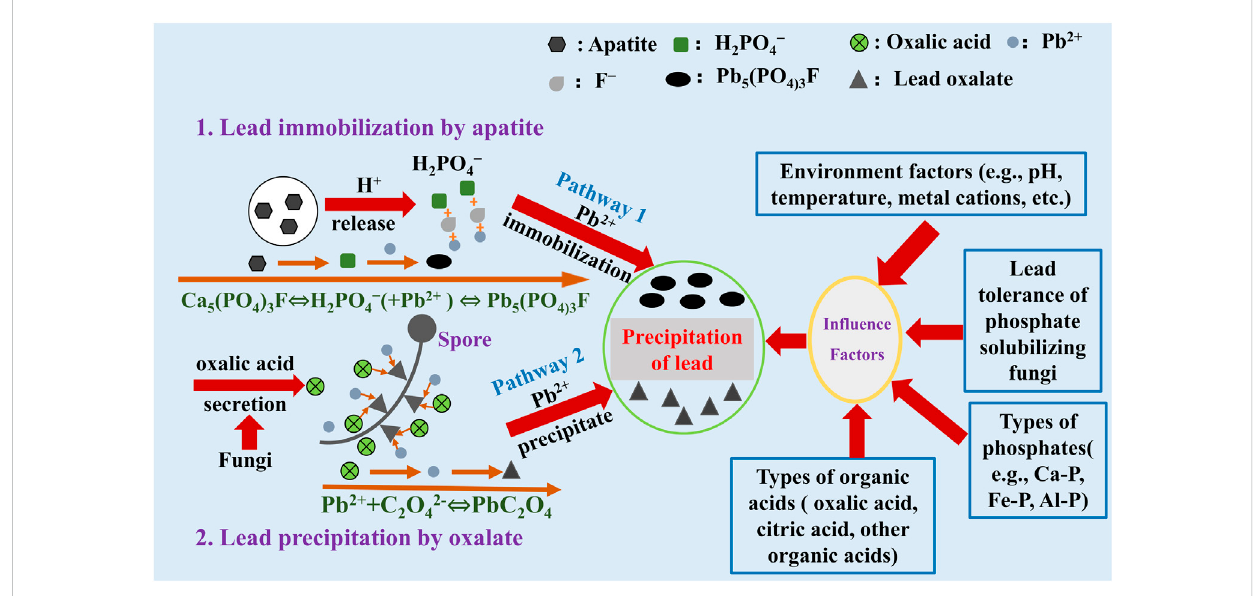
FIGURE 1 Lead remeditaion by phosphate solubilizing fungi and phosphate via the secretion of organic